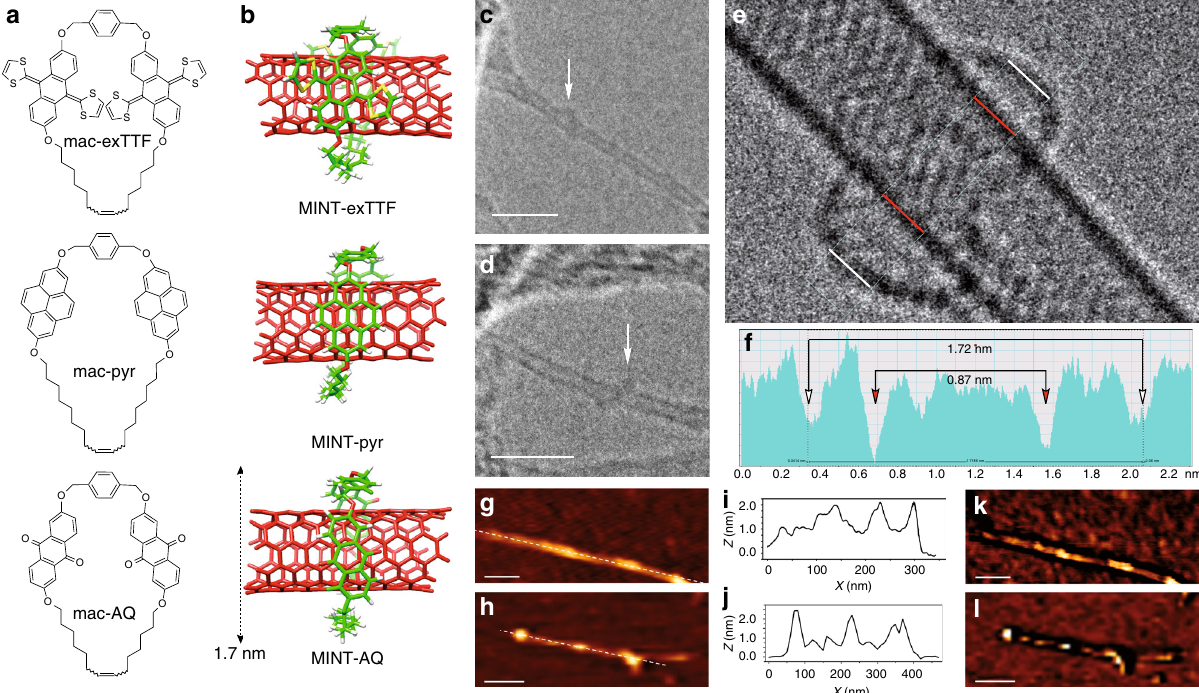
Fig. 1 Structures and microscopy. a Chemical structure of the macrocycles and b minimum energy (DFT) geometries of the corresponding MINTs with (6,5)-SWNTs. The calculated diameter of MINT-AQ is shown for comparison with the microscopy images. c , d Representative TEM images of MINT-AQ, showing SWNTs surrounded objects of adequate size (ca. 2 nm) and shape to be mac-AQ. Scale bars are 5 nm. e ac-HRTEM image of a single MINT-AQ, and f its corresponding analysis along the box depicted with thin white and red lines. g – l AFM characterization of MINT-AQ. We observe isolated SWNTs with protrusions of around 2 nm ( g , h ), as shown in the pro fi les along the white dashed lines ( i , j ). The phase images ( k , l ) show energy dissipation contrast at the protrusions. Scale bars are 50 nm ( g , k ) and 100 nm ( h , l